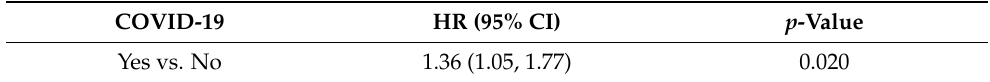
Table 2. Hazard rate and corresponding 95% confidence interval from a time-varying exposure (COVID-19) Cox PH model for repeated outcomes